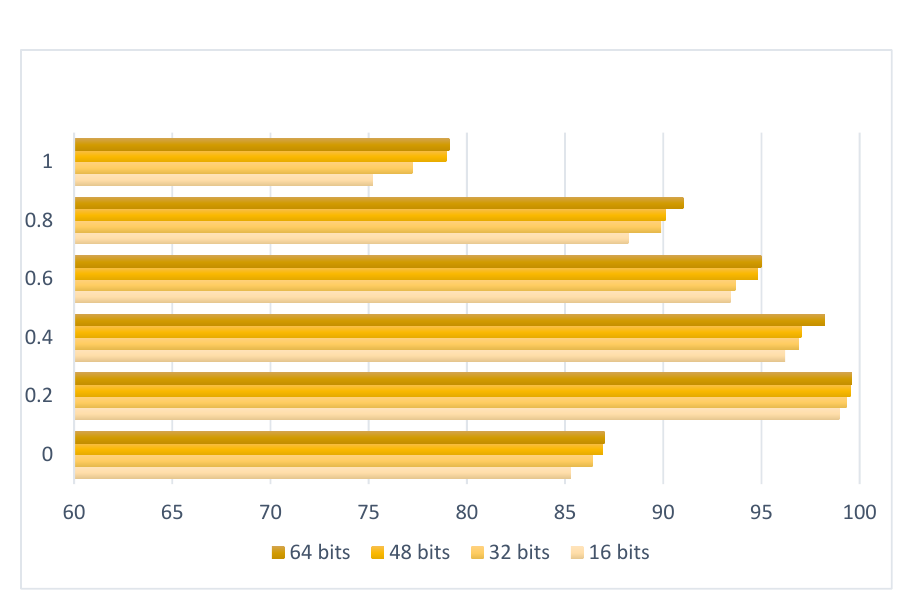
Figure 7. Comparison of different 𝜂 values on UCMD. When 𝜂 = 1 , because only classification loss is used, the samples do not maintain a good distribution in the embedded space and we obtain the worst result, which is consistent with our conclusion in Figure 3. When 𝜂 is 0.2, 0.4, 0.6 and 0.8, we obtained better results than by using only metric-learning loss and achieved the best results at 𝜂 of 0.2.